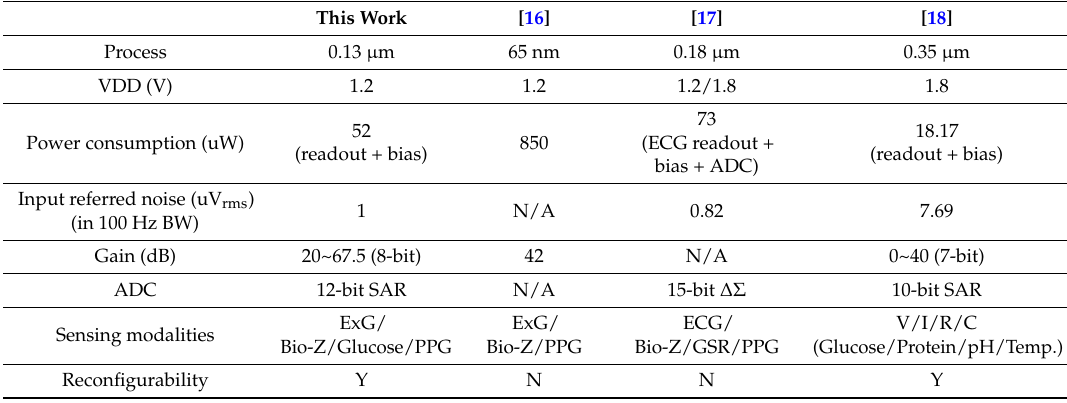
Table 1. Performance